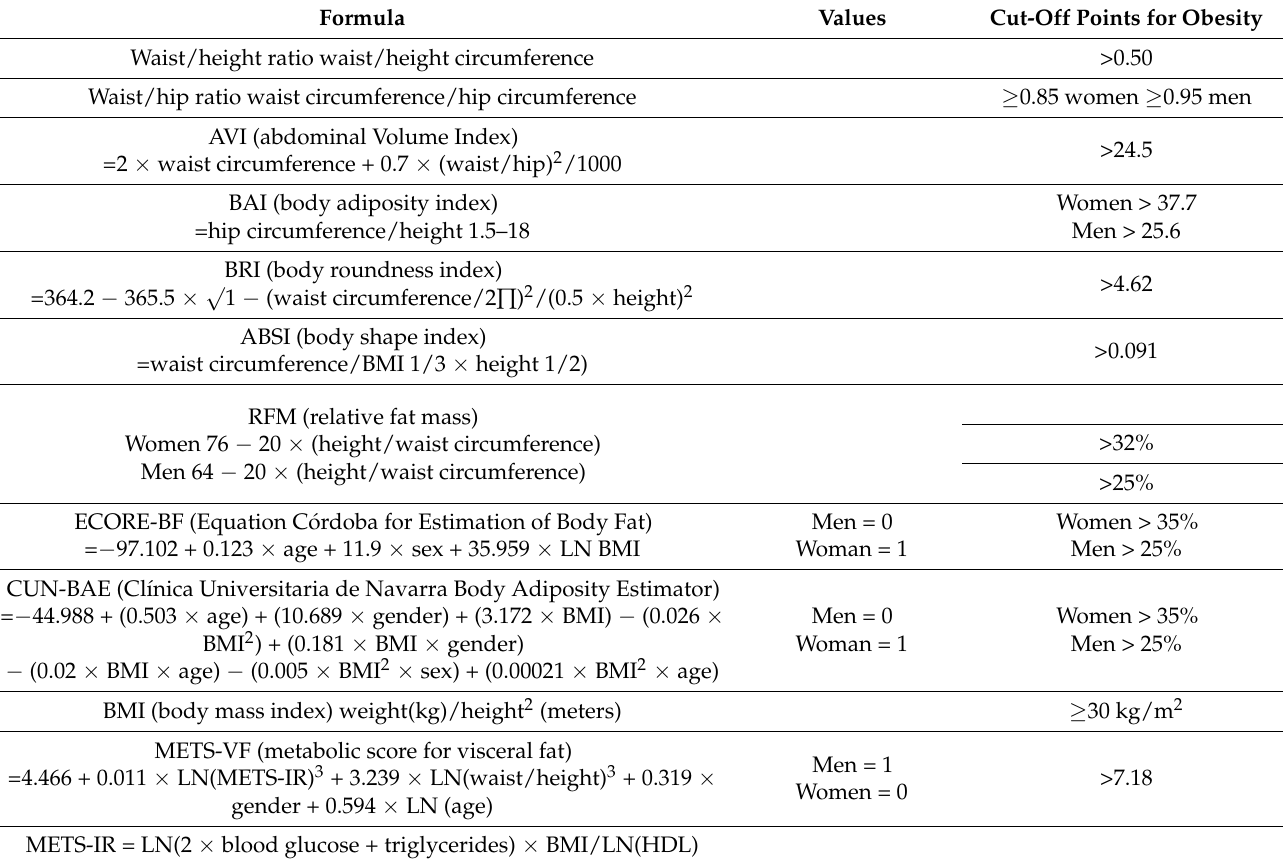
Table 1. Formulas to calculate obesity used in the